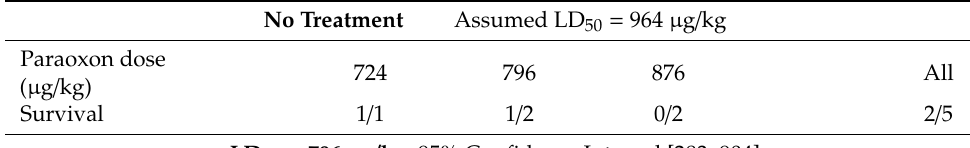
Table 7. LD 50 estimation using the up-and-down method for untreated mice or injected intraperitoneally at the dose of 100 µ mol / kg of 2-PAM or KM297 HCl and 62 µ mol / kg of KM297 HCl one minute after paraoxon subcutaneous challenge. An LD 50 value is initially assumed at the beginning of each experiment with sigma = 0.0414 ( = log 1.1). The LD 50 values were calculated using the AOT 425 Pgm software.